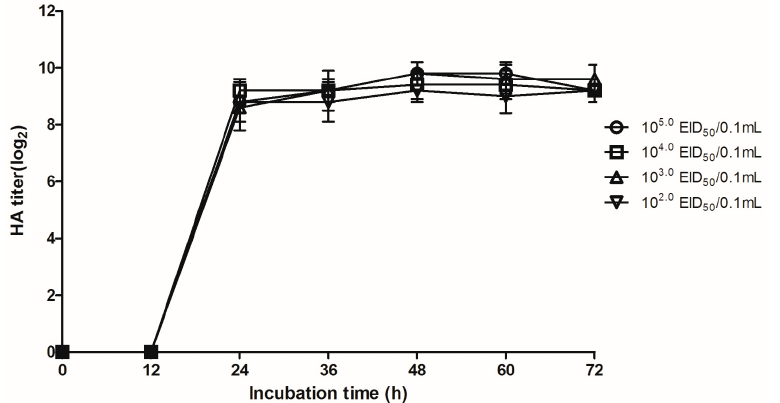
Figure 1. Growth of vac564 (10 2.0 –10 5.0 EID 50 /0.1 mL) in specific-pathogen-free (SPF) eggs over time. Error bars indicate standard deviation of the hemagglutination activity (HA) titers ( n = 5) by inoculating